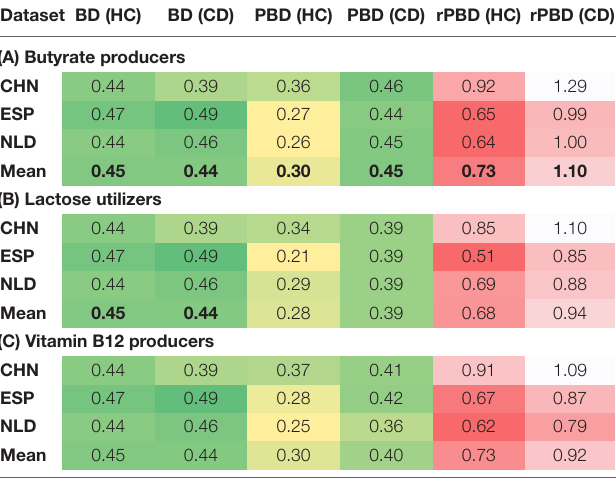
TABLE 4 | Intragroup similarity of carriers of selected three metabolic phenotypes in the HC and CD groups. Dataset BD (HC)